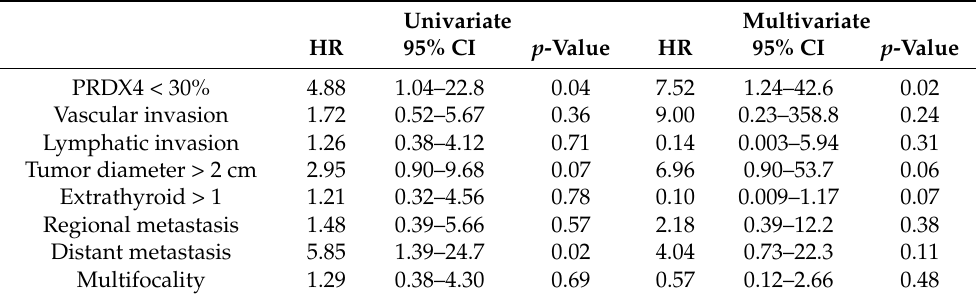
Table 3. Univariate and multivariate analyses of survival according to the PRDX4 expression la- belling index.